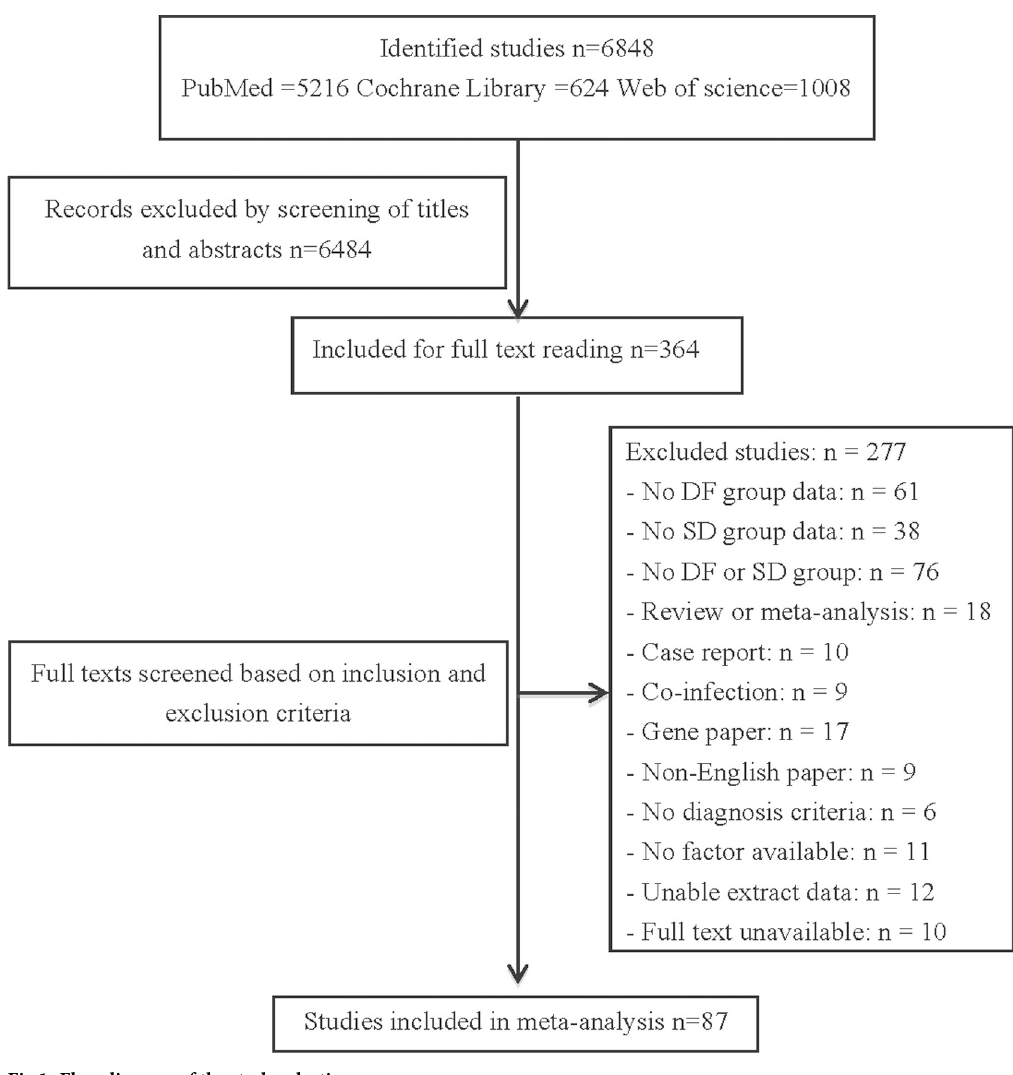
Fig 1. Flow diagram of the study selection